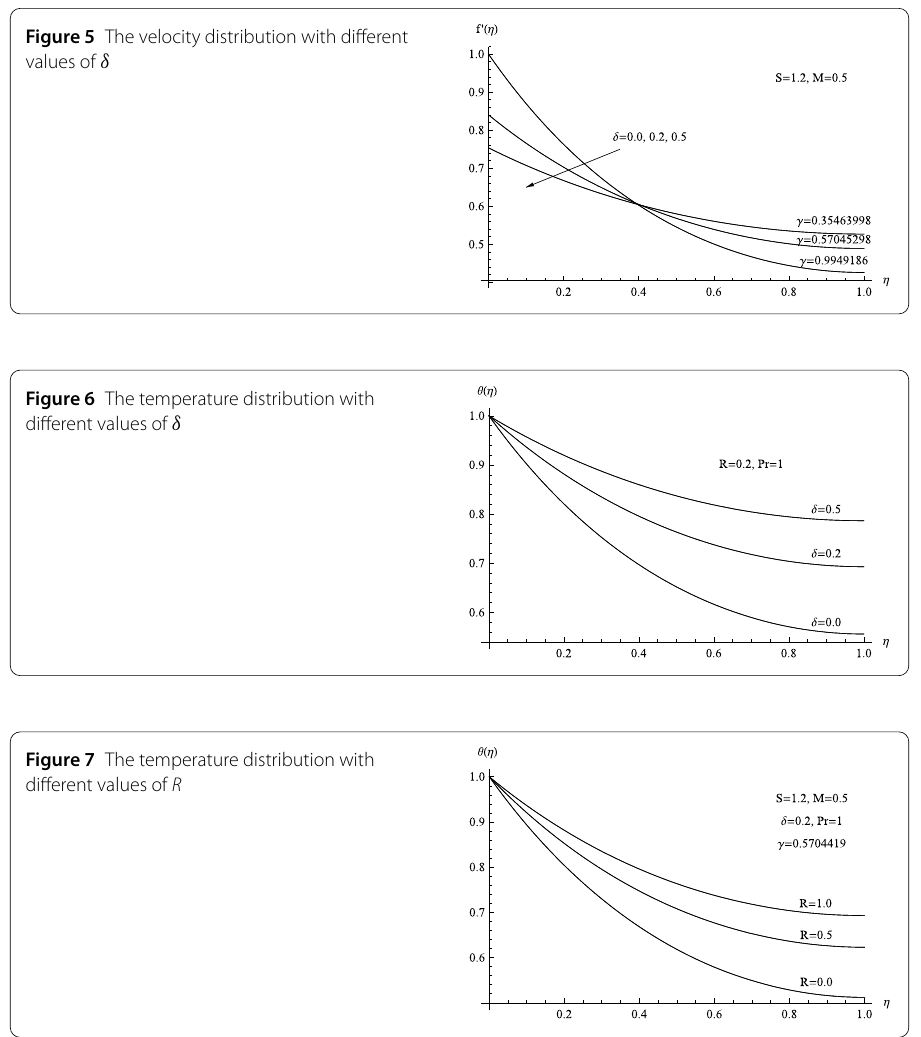
Figure 5 The velocity distribution with different values of δ